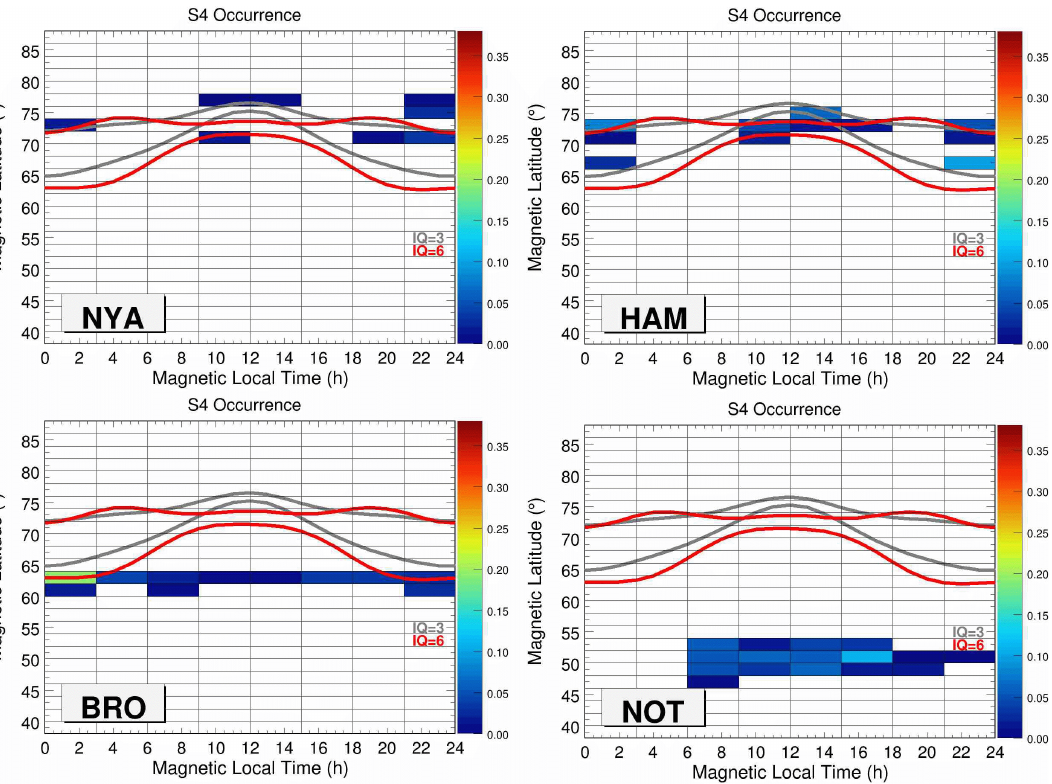
Fig. 8. Amplitude scintillation maps of all days and for stations NYA, HAM, BRO and NOT separately. In grey the Feldstein oval for IQ=3, while in red the one for